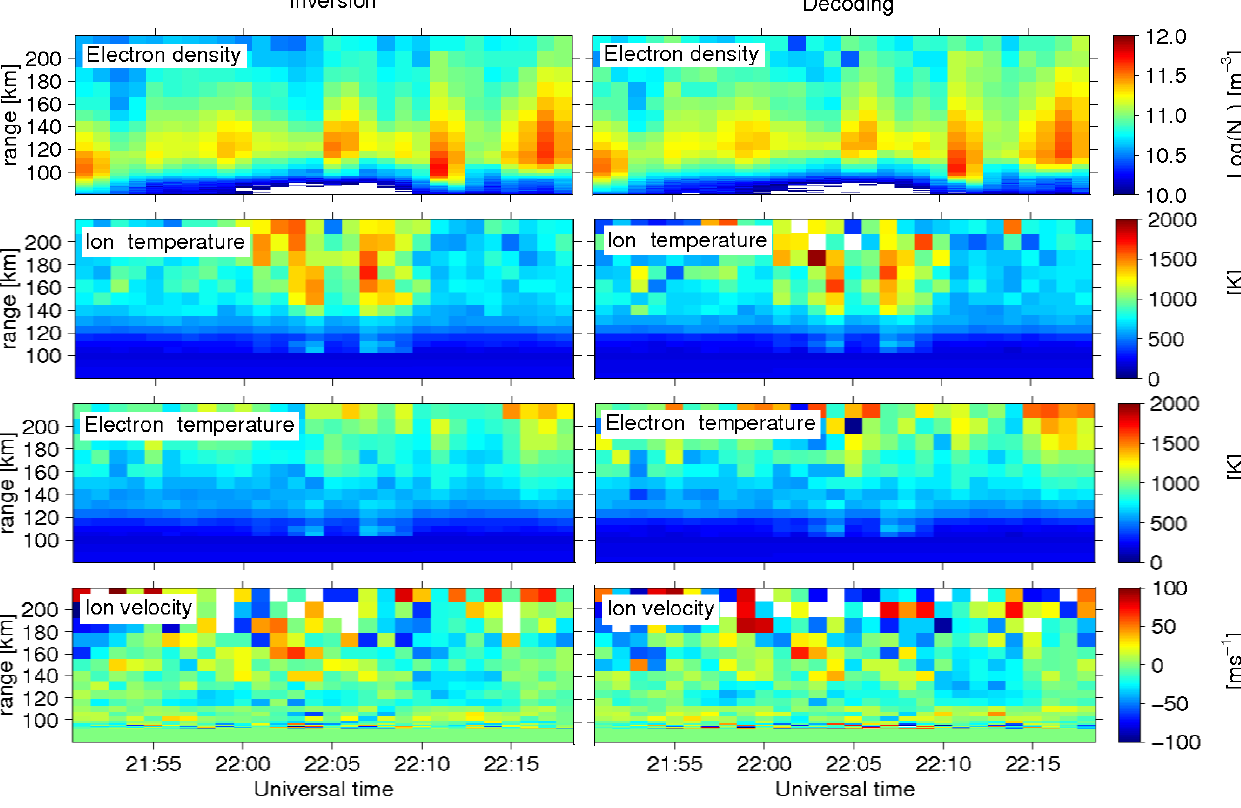
Fig. 5. Fitted plasma parameters by means of the inversion method and standard decoding with GUISDAP. The time period is the same as in Fig. 4 (25 November